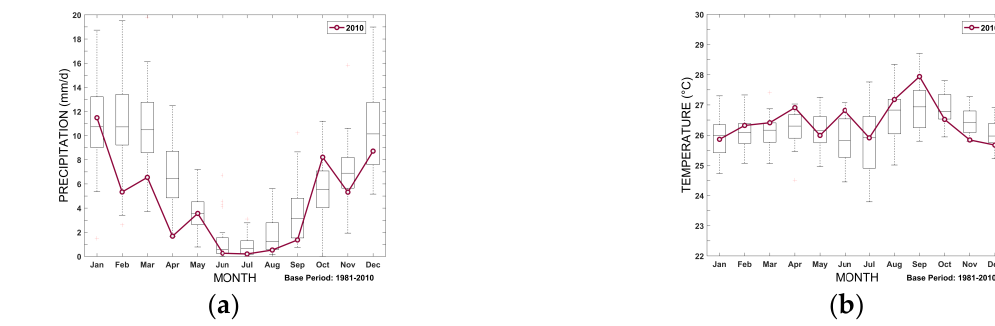
Figure 6. The same as Figure 4 but for Vilhena station in Rond ô nia (RO) and for 2010 (red